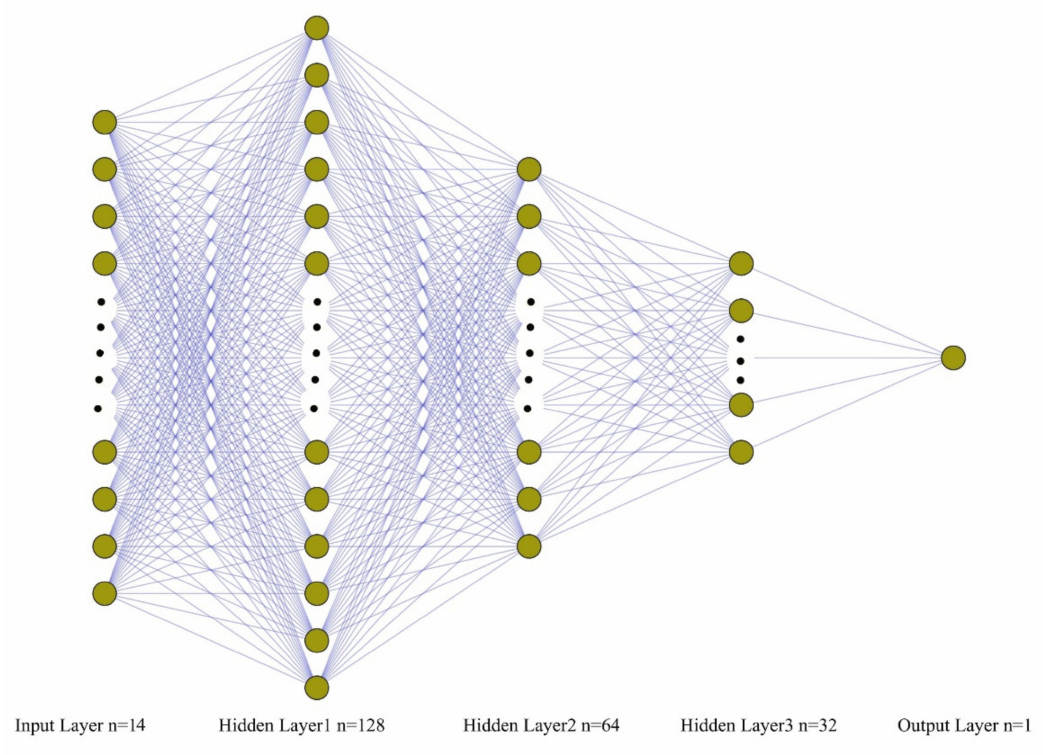
Figure 3. The structure of the neural